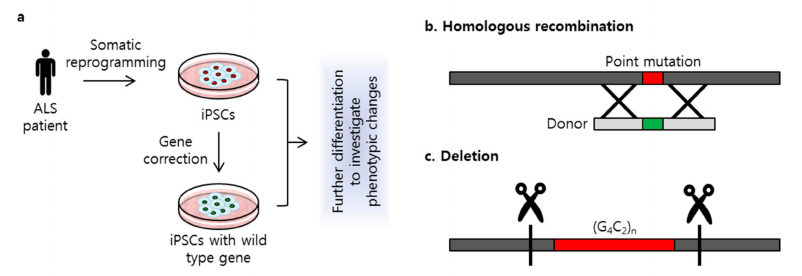
Figure 2. Strategy of clustered regularly interspaced short palindromic repeats / CRISPR-associated system 9 (CRISPR / Cas9)-mediated gene correction. ( a ) Patient-derived induced pluripotent stem cells (iPSCs) were used to perform gene correction. Isogenic cell line was generated to investigate phenotypic changes comparing iPSCs with genetic mutation; ( b ) A point mutation was target specific corrected using a donor via homology-directed repair (HDR) mechanism; ( c ) Repeat expansion in C9orf72 was deleted with two